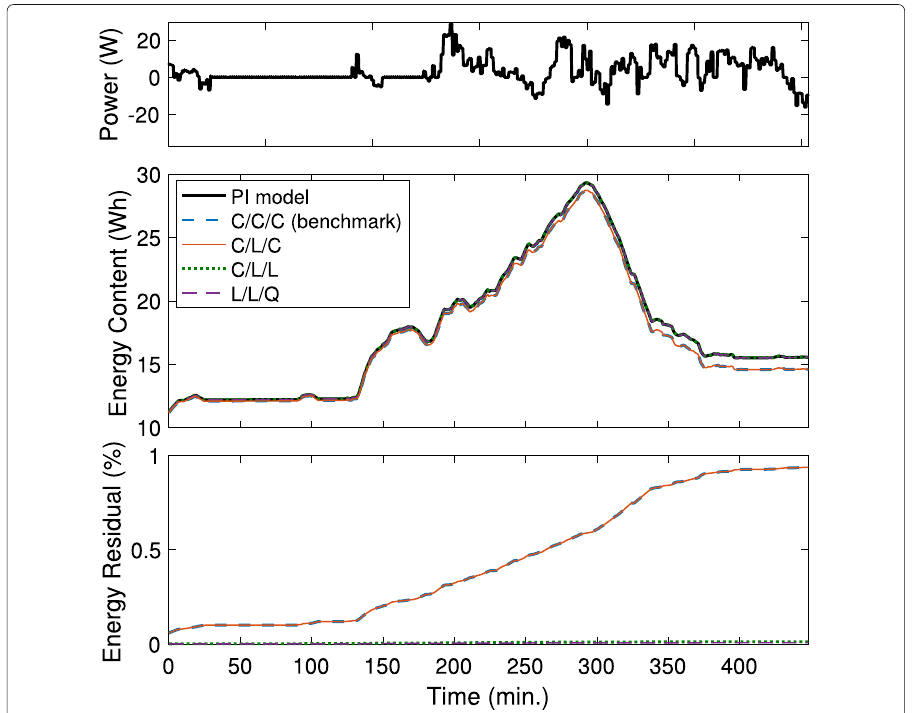
Fig. 6 The energy content over 8 hours in a realistic deployment charge/discharge profile. The residual between the analytic models and the PI model (bottom), as well as the applied power trace (top), are also